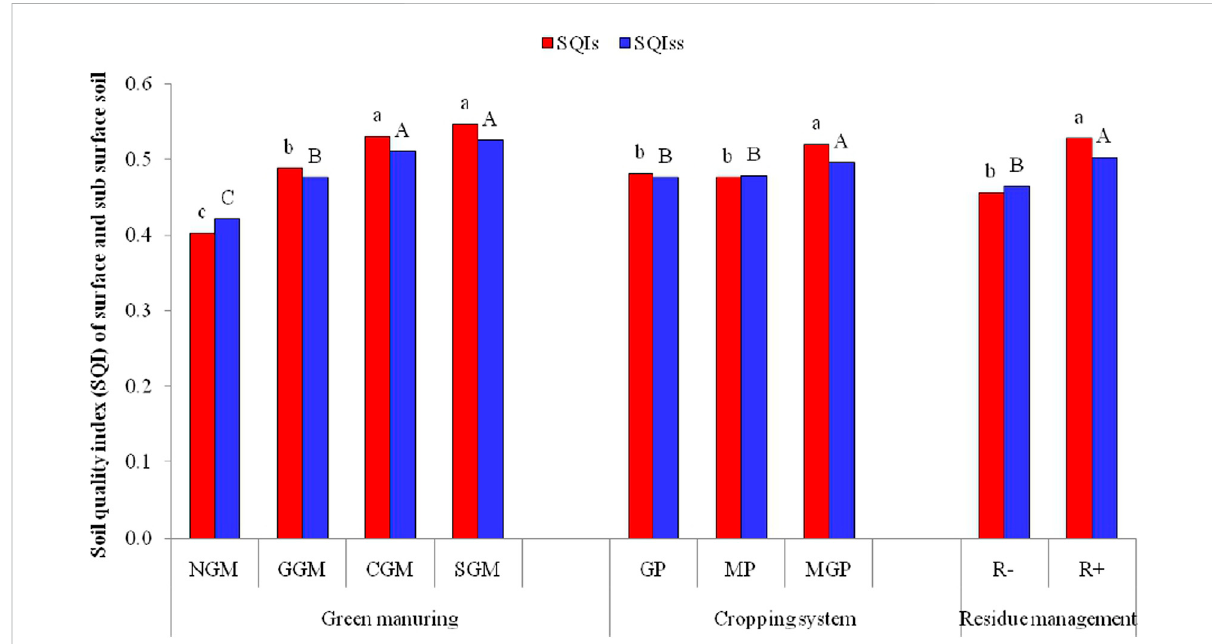
FIGURE 5 Soil quality index of surface (0 – 0.15 m) and subsurface soil (0.15 – 0.45 m) as in fl uenced by green manuring, cropping systems, and residue management Green manuring, cropping system, and residue management followed by different letters in surface (a – c) and subsurface (A – C) soil is signi fi cantly different at (p < 0 .05). (DMRT: Duncan ’ s Multiple Range Test). NGM: No green manuring, GGM: greengram green manuring, CGM: cowpea green manuring, SGM: sesbania green manuring, GP: groundnut – pea, MP: maize – pea, MGP: maize + groundnut-pea, R-: